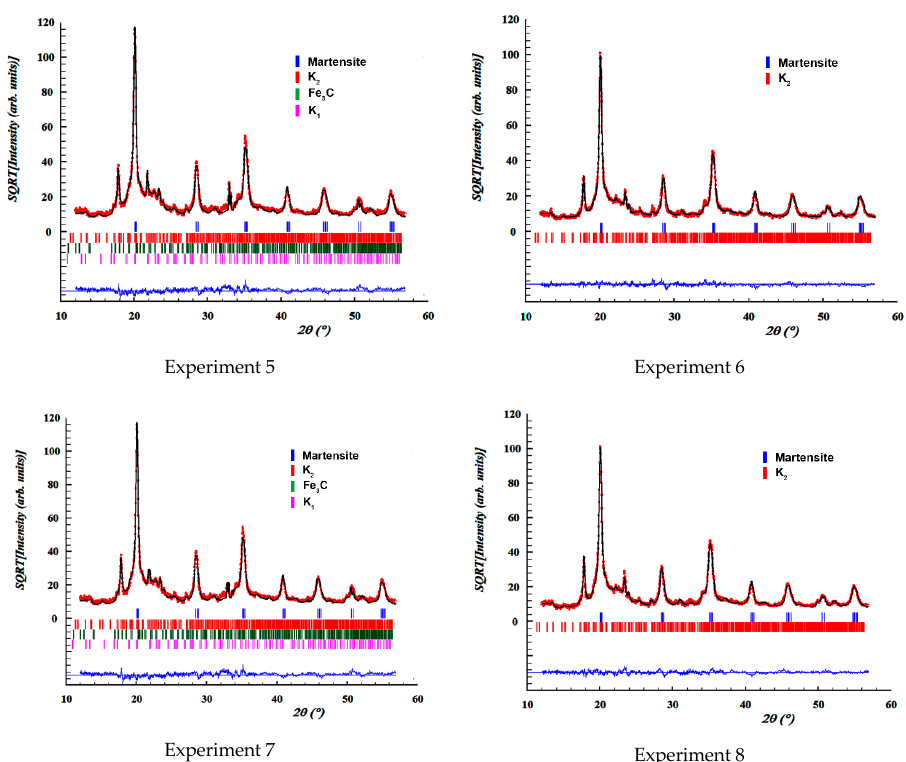
Figure 5. Overall fittings using the Rietveld method. The red marks define the observed intensities. Table 7 shows the percentages by weight and the mesh parameters of the main crystalline phases detected by XRD. The goodness-of-fit is defined by factor Rwp, index Rexp, and the ratio of their squares, Chi 2 = (Rwp/Rexp) 2 . Table 7. Microstructural parameters, weight distributions of the precipitated phases, and volume of austenite. The statistical error is given between parentheses.